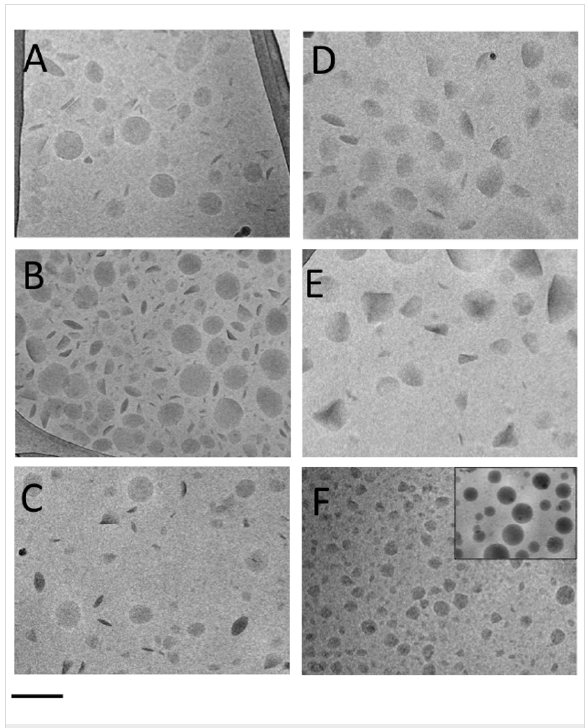
Figure 2: Cryo-TEM images of NLC T10 (A), NLC T10-TOC (B), NLC T10-RA (C), NLC C5-TOC (D), NLC P5-TOC (E), NLC S5-TOC (F). The scale bar below corresponds to 200 nm in panels A–E and 300 nm in panel F.